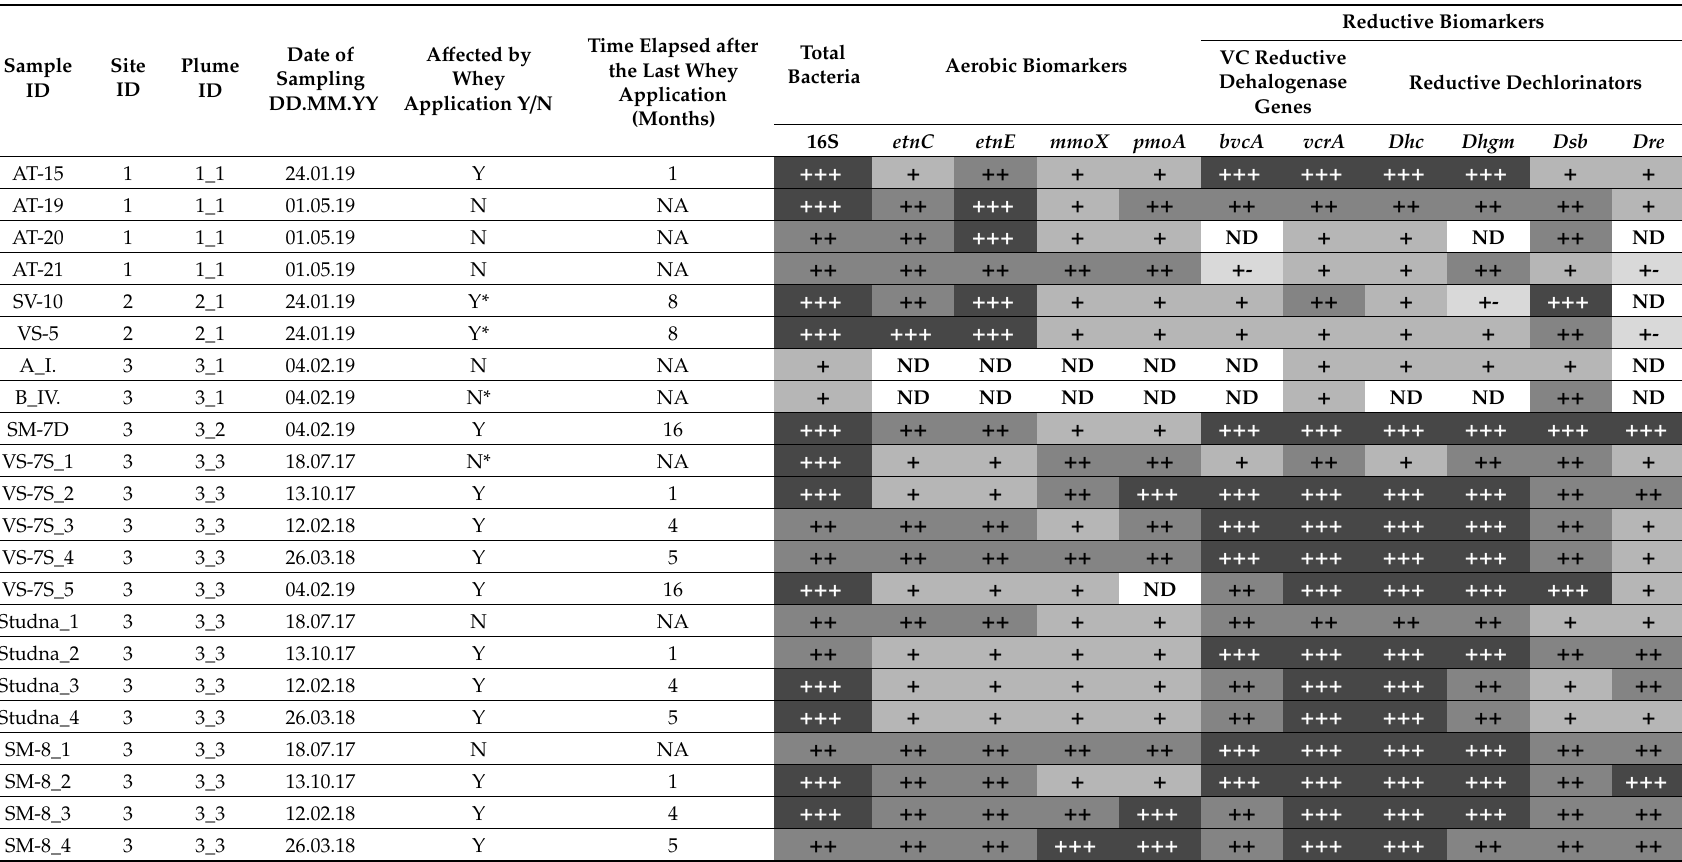
Table 2. Summary of qPCR results (samples are identified based on the well number and time (after underline), site ID refers to Figure 1, plume ID is related to the site ID, and in case that the well was a ff ected by whey application, the time interval is mentioned, for abbreviations see text in Section